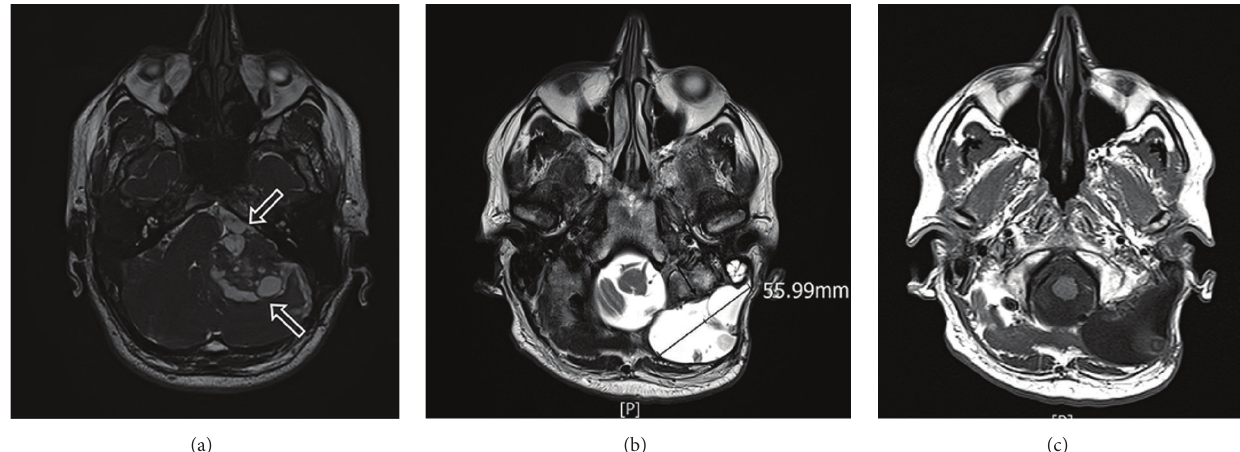
Figure 1: (a) Axial T2-weighed image. Cystic areas of CSF leak consequent to defect of dural repair (white open arrows). (b) Axial T2-weighed image. Hyperintense CSF leak measured 5.6 cm (arrow). (c) Axial T1-weighed image. Hypointense CSF leak.